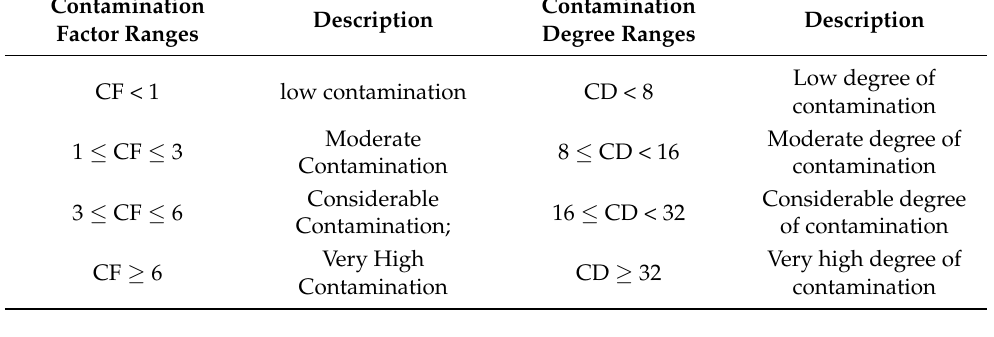
Table 3. Description of Contamination Factor (CF) and Contamination Degree (CD) according to [38].